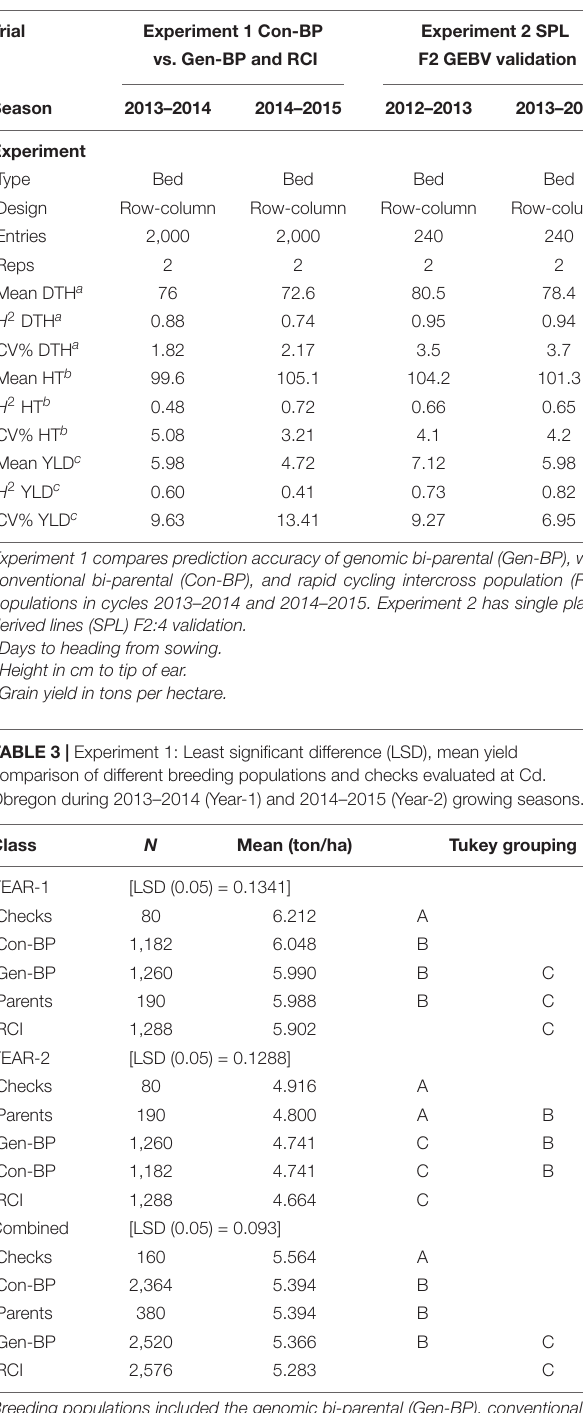
TABLE 2 | Summary field trial data for Experiments 1 and 2.